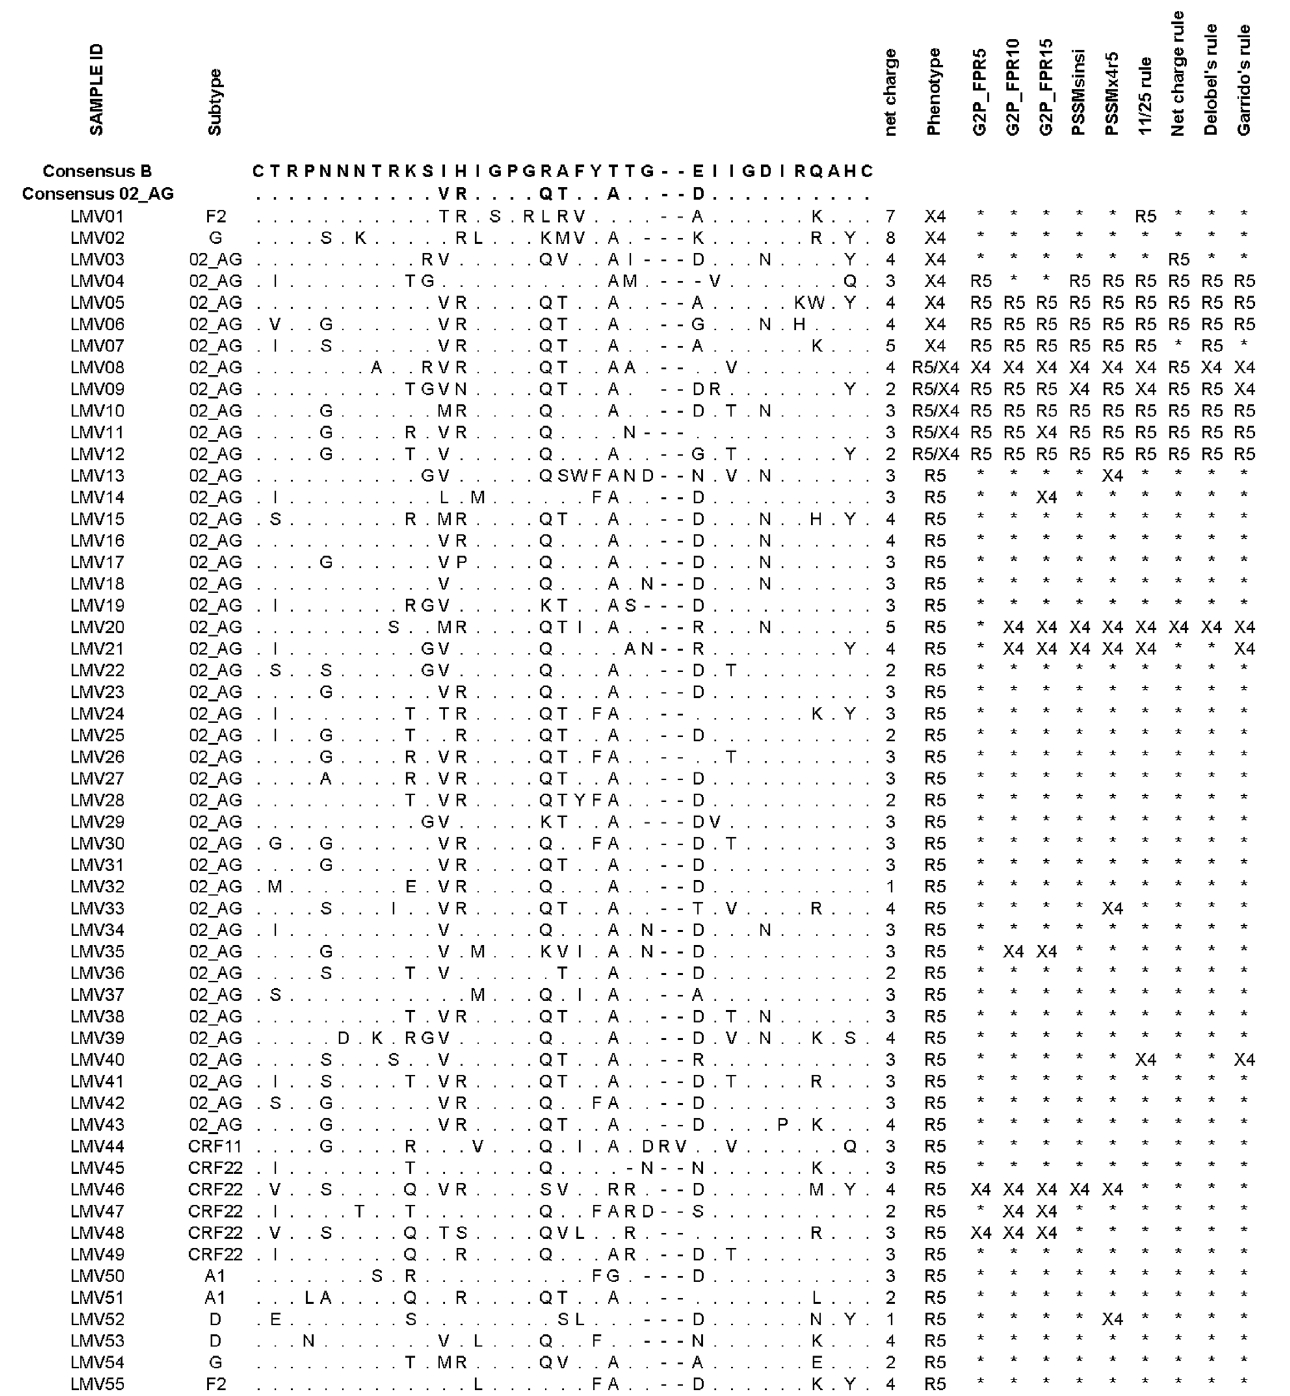
Figure 3. Alignment of V3 sequences from HIV-1 infected plasma from Cameroon. Predictions by different algorithms were compared with phenotype characterization. Concordant genotypic predictions of R5-tropic (R5) or X4-tropic (X4) viruses with virus phenotype were indicated with an asterisk (*). doi:10.1371/journal.pone.0112434.g003 mance of Garrido’s rule was better in terms of specificity (93% vs 84%). With regard to HIV-1 subtype, for 7/9 predictive tools specificity for predicting R5-tropic virus was comparable for both CRF02_AG (87% to 100%) and non-CRF02_AG (83% to 100%)